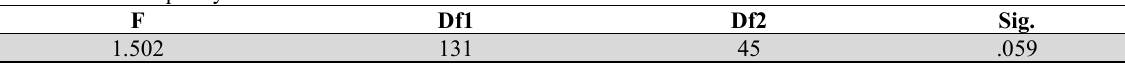
Levene's Test of Equality of Error Variances F Df1 Df2 Sig. 1.502 131